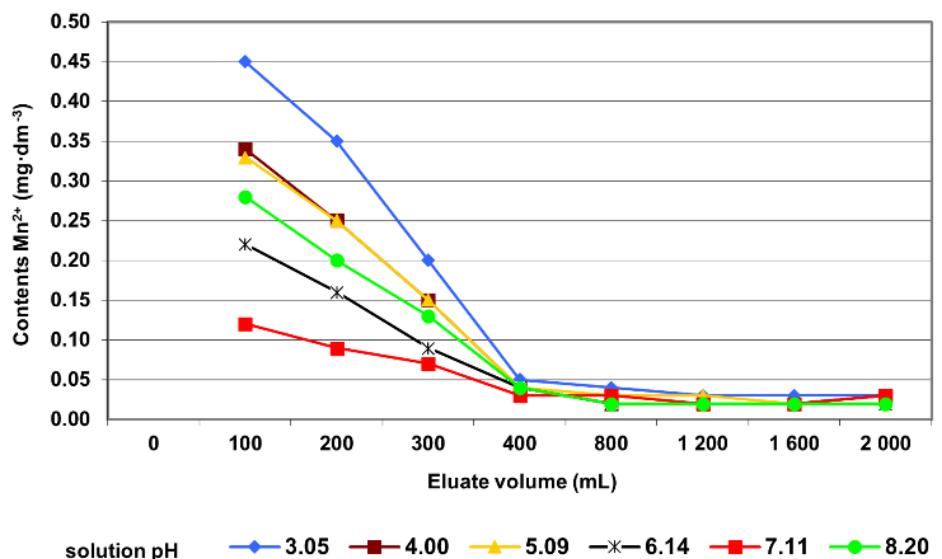
Figure 8. Contents of Mn 2+ ions in successive portions of the collected eluate depending on the pH of the initial leaching solution.